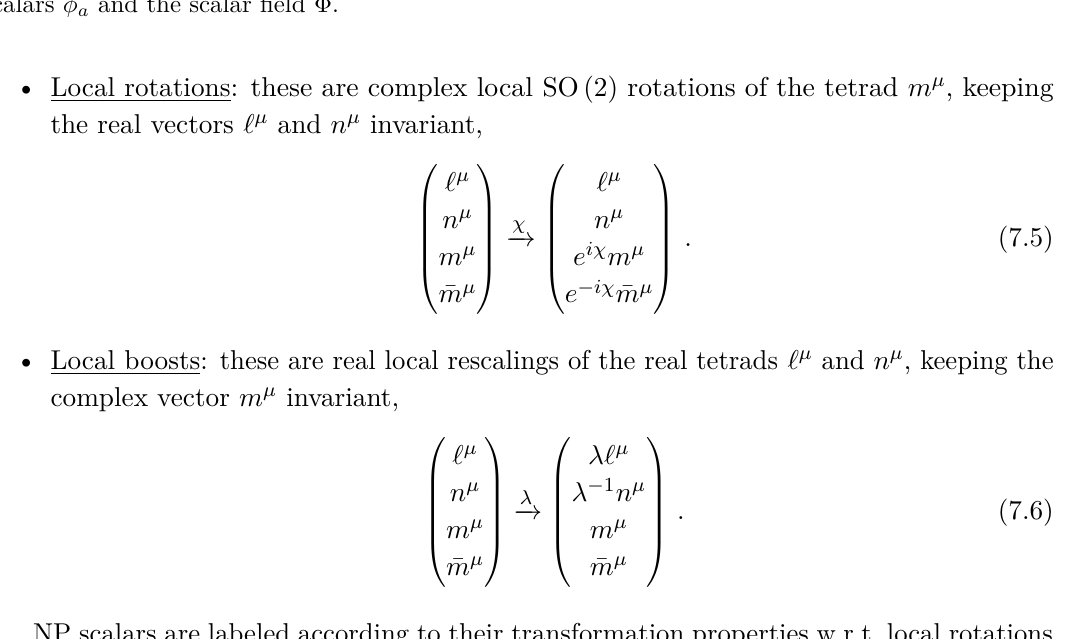
Table 1 . Spin weights, boost weights and GHP weights of the Weyl scalars ψ a , the Maxwell-NP scalars φ and the scalar field Φ a